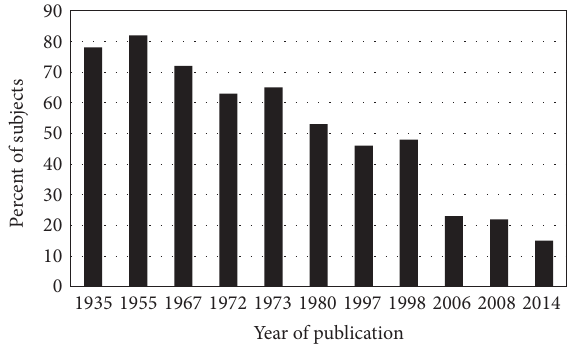
Figure 1: Diabetes in nonscreening hemochromatosis. Percentages of patients diagnosed to have hemochromatosis phenotypes in nonscreening settings who also had diabetes [1, 2, 8–10, 42, 131, 167– 169]. HFE mutation genotyping was a diagnostic adjunct in three studies [1, 2, 10].